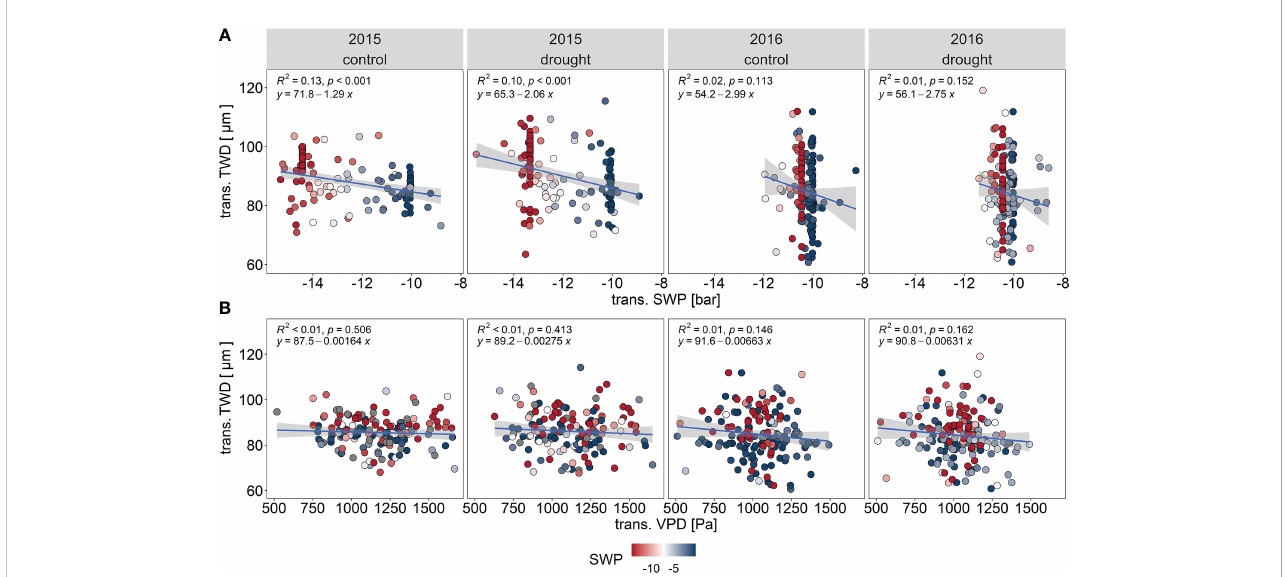
FIGURE 6 Responses of transformed tree water de fi cit TWD to microclimatic conditions in control (PC) and drought (PE) stands in 2015 and 2016: transformed mean soil water potential SWP (A) , and transformed vapor pressure de fi cit (VPD) (B) . The values are derived from the Cochrane-Orcutt